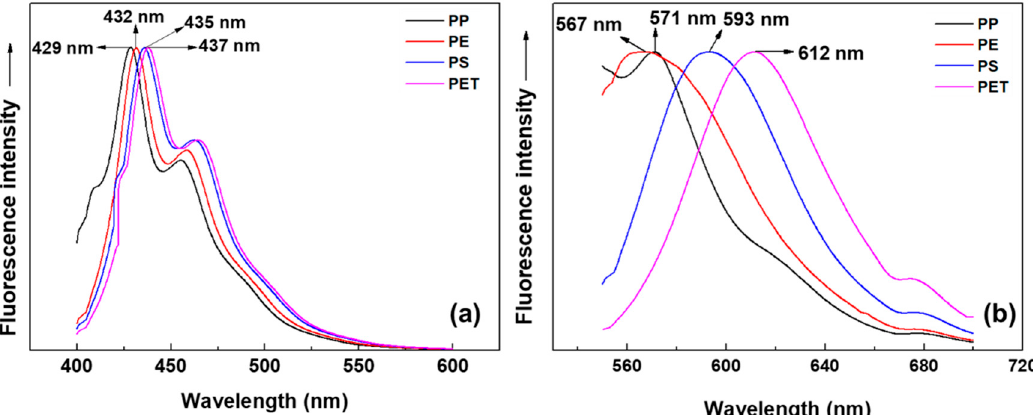
Figure 4. Normalized fluorescence spectra of S-FN ( a ) and Nile red ( b ) in stained MPs. Staining conditions: surfactant = Tween 20; dye/surfactant = 1 g/L; dye/MP = 2.5 wt%; MP/aqueous solution = 1 g/L; staining time = 60 min; staining temperature = 80 °C.